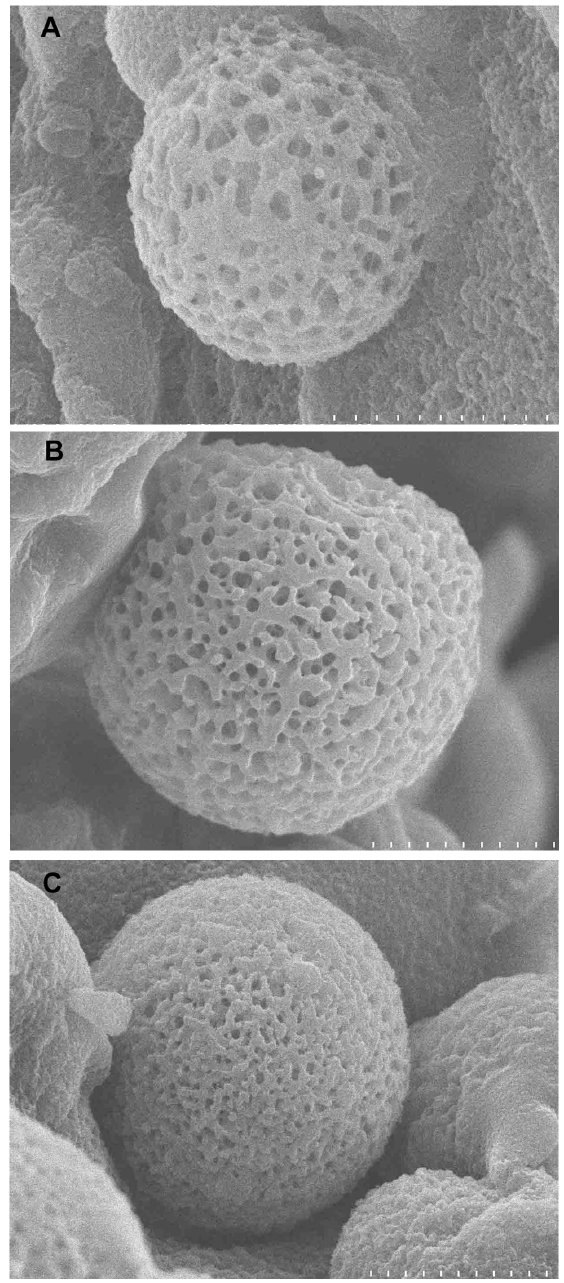
Figure 1. SEM micrographs of microspheres cross-linked with alginate and hyaluronate. (A) Micrograph of cross-linking for 0.5 h with a measurement unit of 4 m m fewer than 12,000 magnifications. (B) Micrograph of cross-linking for 1 h with a measurement unit of 10 m m fewer than 4,000 magnifications. (C) Micrograph of cross-linking for 2 h with a measurement unit of 10 m m fewer than 4,000